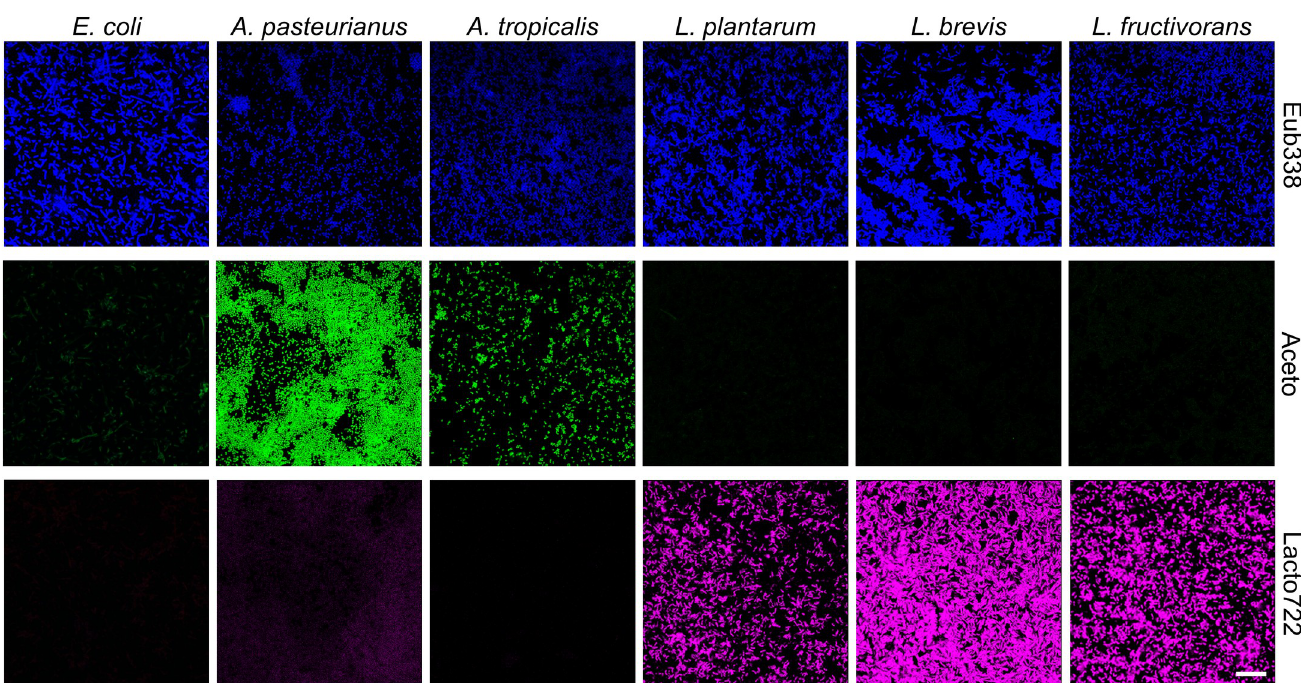
Fig 1. Validation of the probe specificity for fluorescence in situ hybridization (FISH) using bacterial cell suspensions. FISH was performed with PFA-fixed bacterial cell suspensions of E . coli , A . pasteurianus , A . tropicalis , L . plantarum , L . brevis , and L . fructivorans with the three different probes Eub338 (blue), Aceto (green), and Lacto722 (red) (4 μ M/probe) and 40% formamide for three hours at 46˚C. Lactobacillus strains were treated with 10 mg/ml lysozyme for 15 minutes at 37˚C prior to the hybridization. Each bacterial species sample was individually stained with the respective probe and the figure only shows the corresponding images for either the Eub338, Aceto or Lacto722 hybridization channel. All images were recorded with the identical settings for each probe channel. To assay for possible fluorescence bleed-through, we recorded for all stainings all three channels (S6 Fig). The figure shows representative examples from at least three separate experiments. Scalebar represents 20 μ